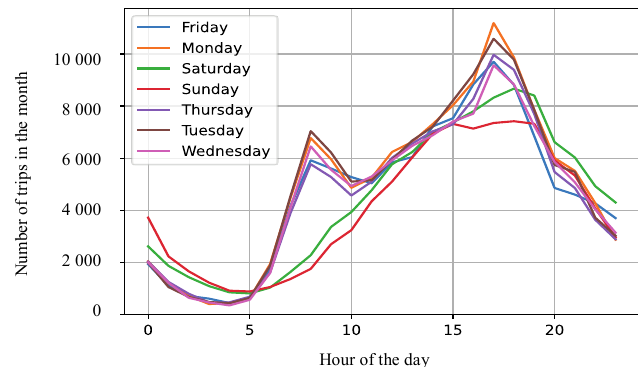
Fig. 7. Number of scooter trips by hour, depending on the day of the